Question: What does this figure show? Answer in one sentence.
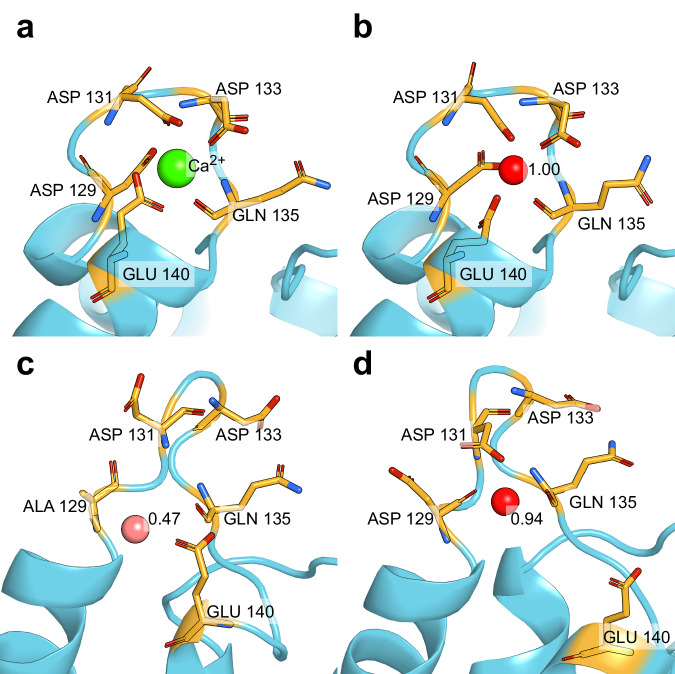
Answer: Point-mutation sensitivity of BiteNet I at the calmodulin EF-hand IV Ca 2+ -binding site. All panels show the EF-hand IV loop with coordinating residues labeled. a Reference Ca 2+ -saturated structure (1CLL), with the experimental Ca 2+ ion shown for context. b Identity-control model (D129D) generated from 1CLL (ions were removed before the generation); the predicted Ca 2+ center (red sphere) and its BiteNet I score (1.00) are shown. c CaM1234 structure (5TP5; D129A), the predicted Ca 2+ (red sphere, score 0.47) corresponds to the highest-scoring NMR model. d Restoring Asp in the CaM1234 structure (A129D) increases the predicted Ca 2+ site score to 0.94.